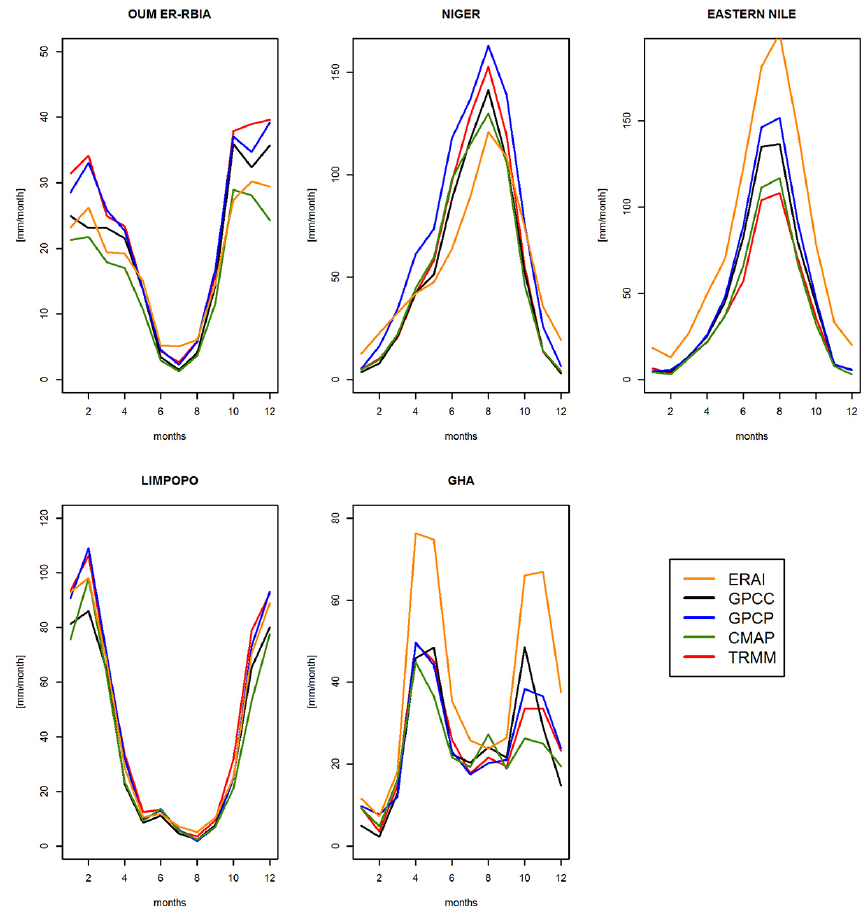
Fig. 3. Mean annual cycle of precipitation from the different data sets averaged over the five regions defined in Fig. 1 (OER: Oum er-Rbia, NIG: Inner Niger Delta, NIL: Eastern Nile, LIM: Limpopo Basin and GHA: Greater Horn of Africa) for the common period 1998–2010.